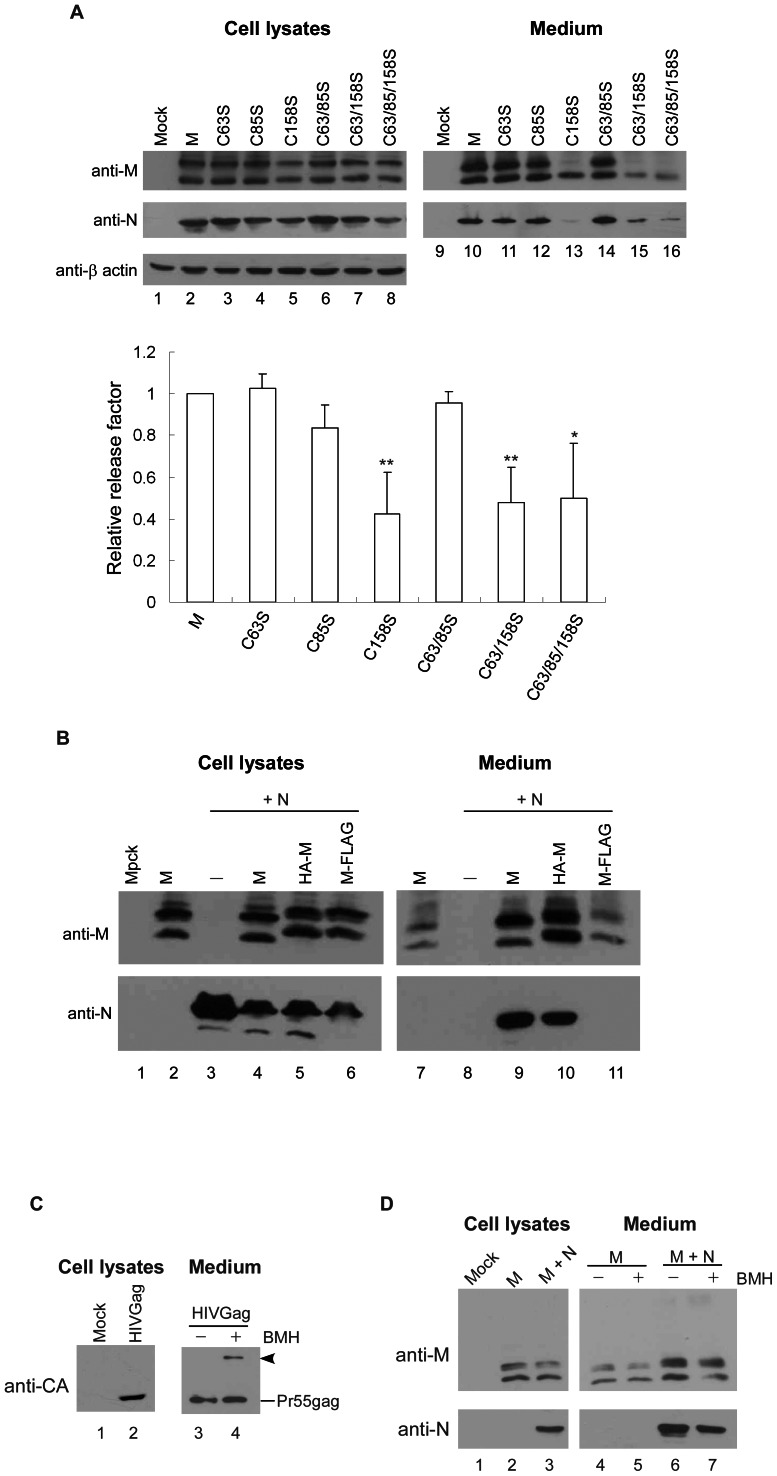
Mutational effects on M protein release and VLP assembly. (A) Results from analysis of SARS-CoV M cysteine residues in VLP assembly.(A) 293T cells were cotransfected with SARS-CoV N and indicated wt or mutant M expression vector. C63/85S, C63/158S and C63/85/158S designate combined double or triple alanine substitutions in cysteine residues 63, 85 and 158. At 24 to 36 h post-transfection, supernatants and cells were collected and prepared for protein analysis. Medium pellet samples corresponding to 50% of total and cell lysate samples corresponding to 5% of total were fractionated by 10% SDS-PAGE and electroblotted onto nitrocellulose filters. SARS-CoV M was probed with rabbit antiserum, and N was detected with a mouse anti-N monoclonal antibody. M proteins in medium or cell samples were quantified by scanning mutant and wt M band densities from immunoblots. Ratios of M levels in medium to those in cells were determined for each mutant and normalized to wt medium/cell ratios in parallel experiments. Error bars indicate standard deviations. *, p<0.05; **, p<0.01. (B) A FLAG tagged at the M carboxyl terminus prevents VLP assembly. 293T cells were transfect with SARS-CoV N alone or together with the indicated wt or mutant M expression vector. At 24 to 36 h post-transfection, supernatants and cells were collected and prepared for protein analysis as described above. (C–D) Results from cross-linking analyses of SARS-CoV M and HIV-1 Gag proteins. Extracellular particles isolated from 293T culture supernatants expressing SARS-CoV M, M plus N, or HIV-1 Gag were mock-treated or treated with the cysteine-specific cross-linking chemical BMH (panel C, lane 4 and panel D, lanes 5 and 7) as described in Materials and Methods. Samples were subjected to Western immunoblotting following 1 h incubation at room temperature. Arrowhead indicates Pr55gag dimer position.